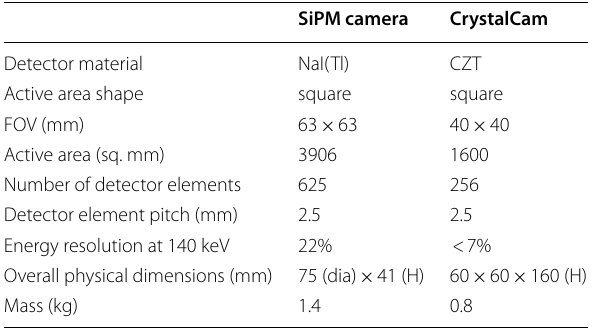
Table 2 SLN radioactive decay for each of the five cases in this study. In the three cases shaded, less than 15% of the SLN activity present at lymphoscintigraphy remained at probe fhSPECT or camera fhSPECT imaging